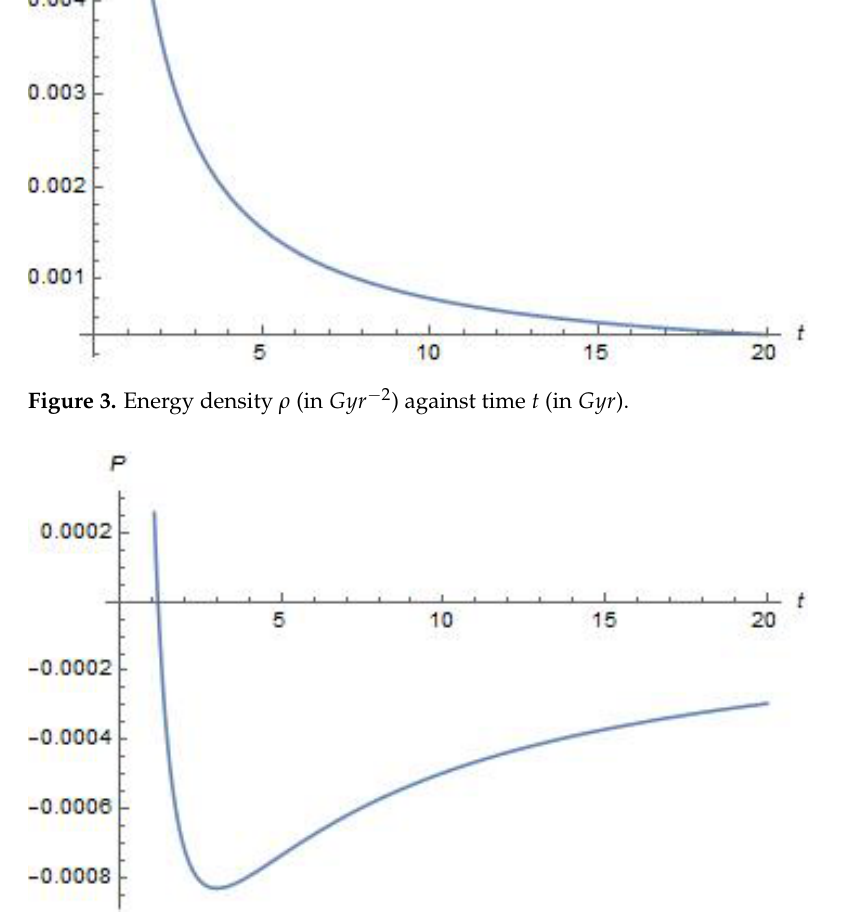
Figure 4. Pressure p (in Gyr − 2 ) against time t (in Gyr